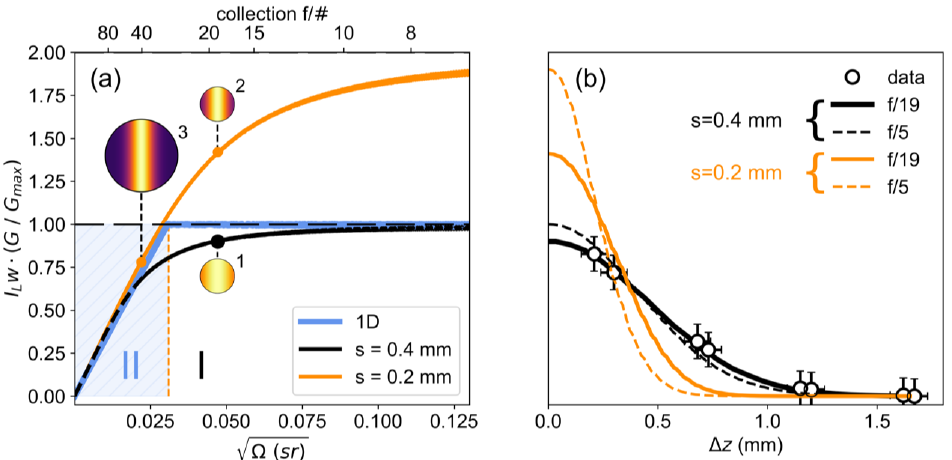
Figure 2. ( a ) Numerical simulation of the effective optical extent as a function of collection lens solid angle and f-number for a simple one-dimensional case (blue), the Gaussian beam used in the experiment (black), and a hypothetical higher-quality beam with a smaller beam waist (orange). The insets show the simulated intensity distribution on the fiber in three representative cases. The point design used here (case 1) is indicated by the black dot. ( b ) The measured alignment sensitivity (circles) is best reproduced using a Gaussian beam waist of standard deviation s = 0.41 mm (black solid line). The data were obtained by measuring the intensity of the 127 cm − 1 Stokes–Raman scattering line off of the quartz probe as the fibers are translated by ∆ z / M across the beam, where M = 3.7 is the magnification of the collection branch. A much faster (f/5) collection cone (black segmented line) has only a minor effect on the collection efficiency since the beam is larger than the fiber projection in both cases and the optical extent is already close to G max . Overall system throughput could only be increased by reducing the focused beam waist size, although this would occur at the expense of alignment sensitivity (orange